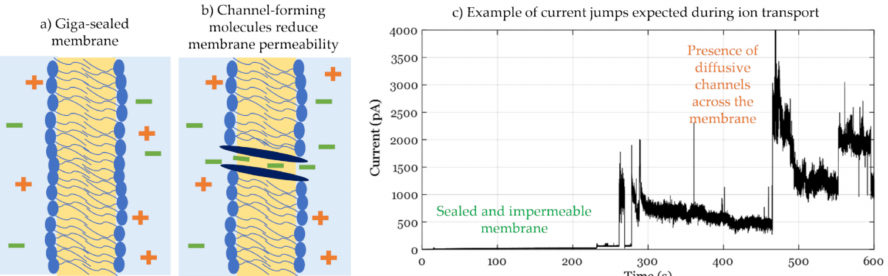
Figure 8. Membrane conductance studies. ( a ) Giga-sealed membranes present tightly packed lipid sheets where the hydrophobic layer inhibits ionic transport ( b ) Once a channel forming molecule–peptides, polymers, or others–integrates across the membrane leaflets, ions transporting channels are created and the gross membrane conductance is increased. This can be detected by applying a constant DC voltage and monitoring the membrane-generated current. ( c ) Adopted from “Makhoul-Mansour, M.M., et al., Photopolymerized microdomains in both lipid leaflets establish diffusive transport pathways across biomimetic membranes. Soft matter, 2019. 15(43): p. 8718-8727”. Example of current behavior upon increase in membrane conductance. Conductance here is induced by the presence of channel-forming photopolymerizable phospholipids in DIBs generating defects in the